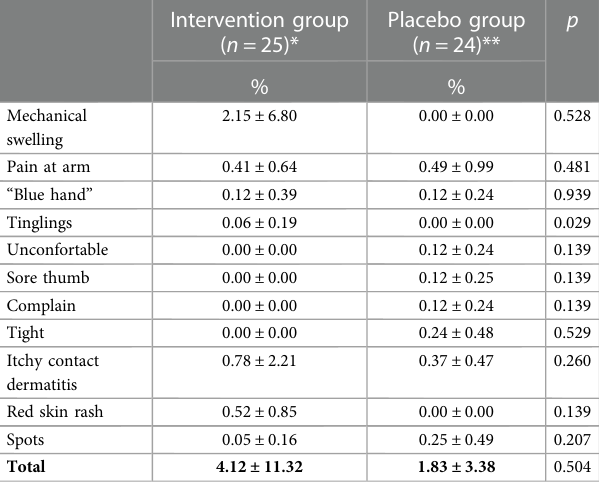
TABLE 4 Frequency of adverse events of interest between UCP children allocation